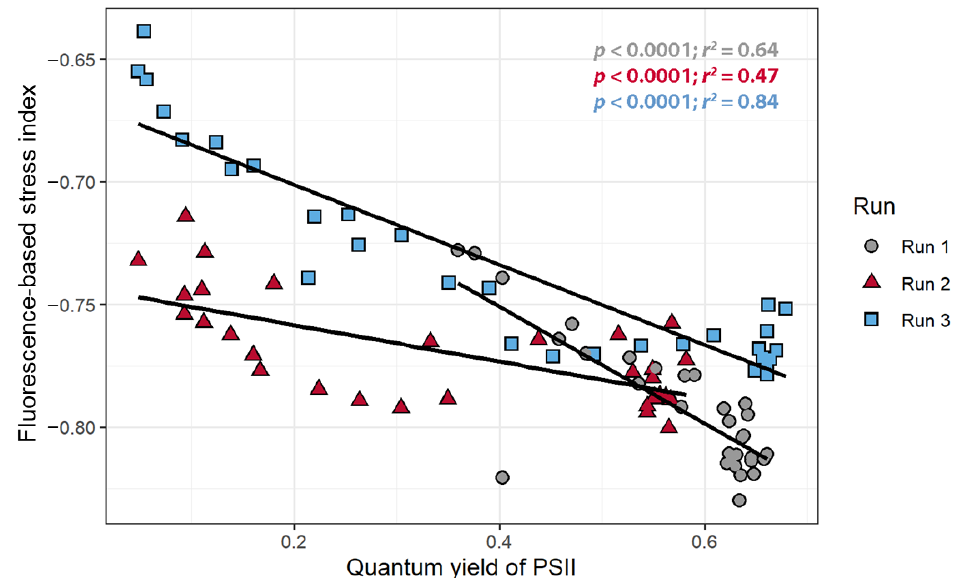
Figure 8. The relationship between the fluorescence-based stress index and the quantum yield of photosystem II of Catharanthus roseus treated with atrazine.